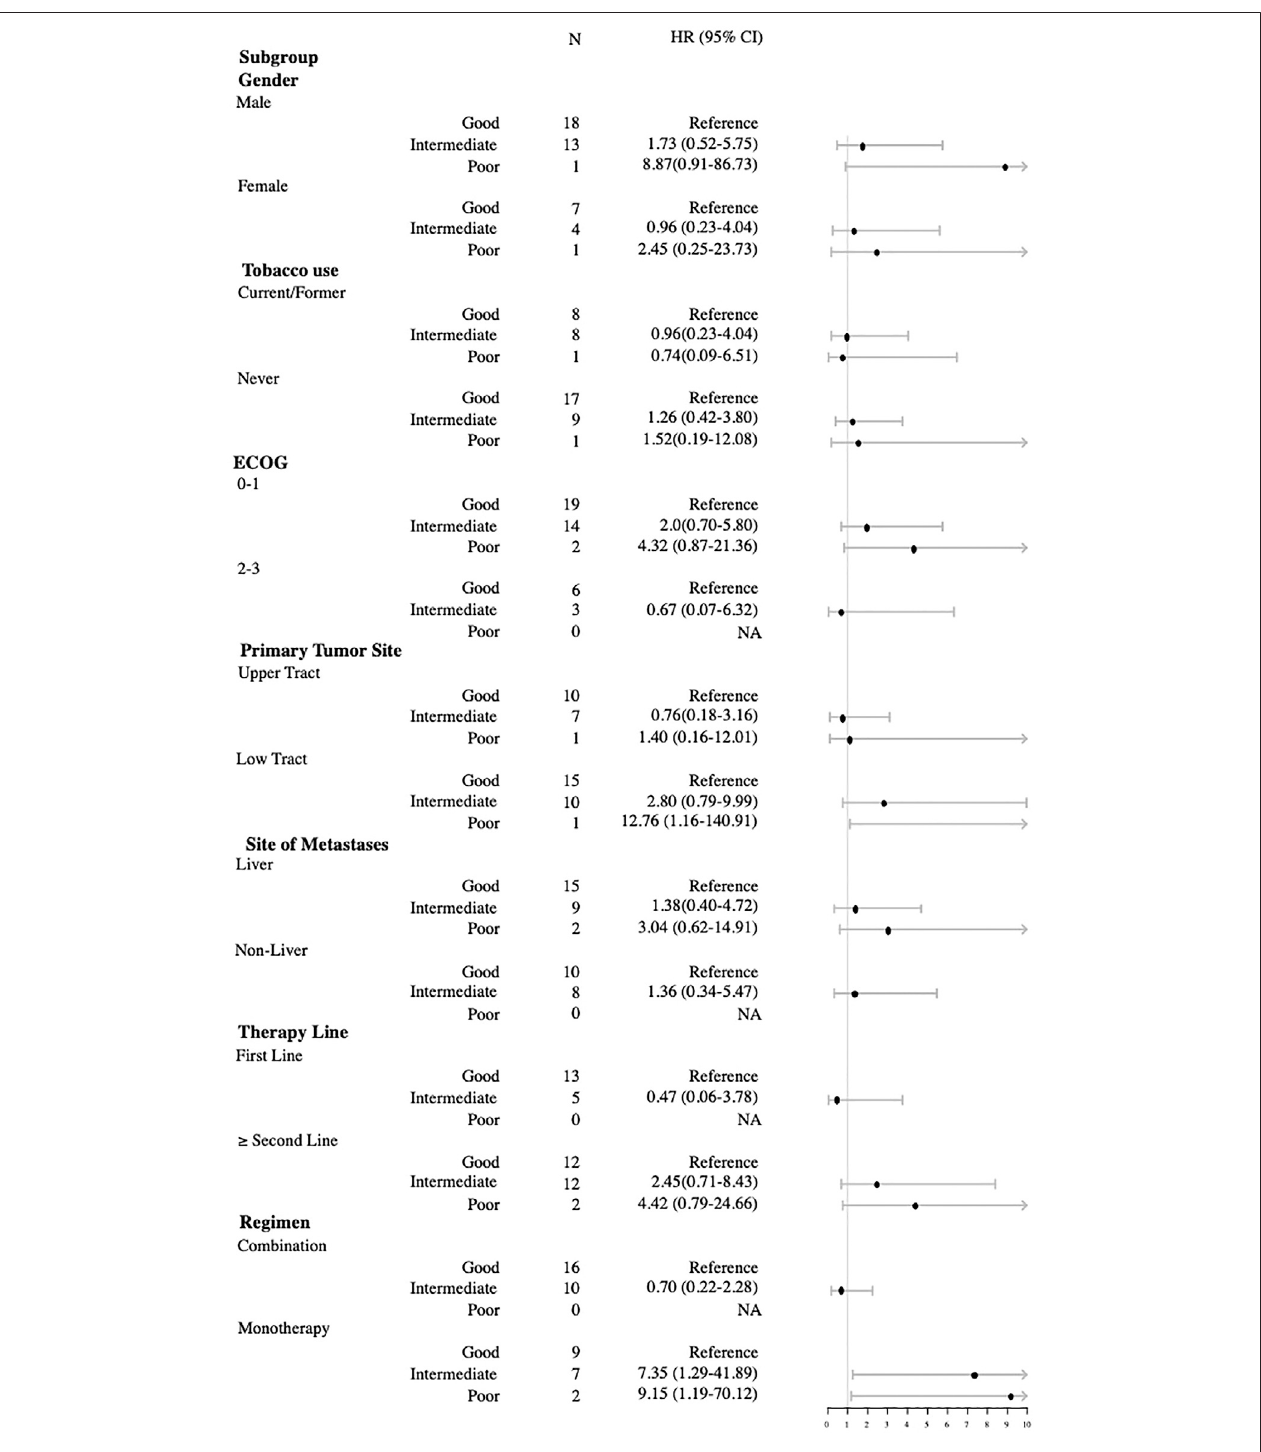
FIGURE 4 | Forest plot of hazard ratios in the subgroup analysis comparing overall survival of mUIPI.